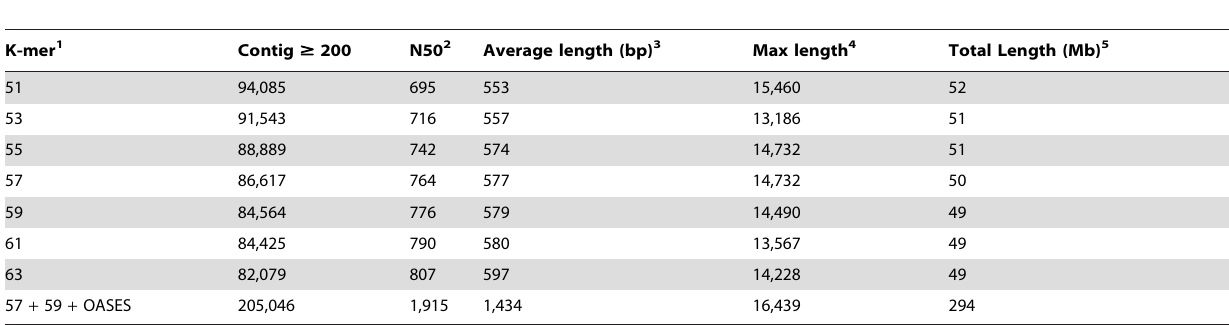
Table 2. Summary statistics of the assemblies of the cabbage sequence data showing the performances of the multiple-k de novo assemblies.